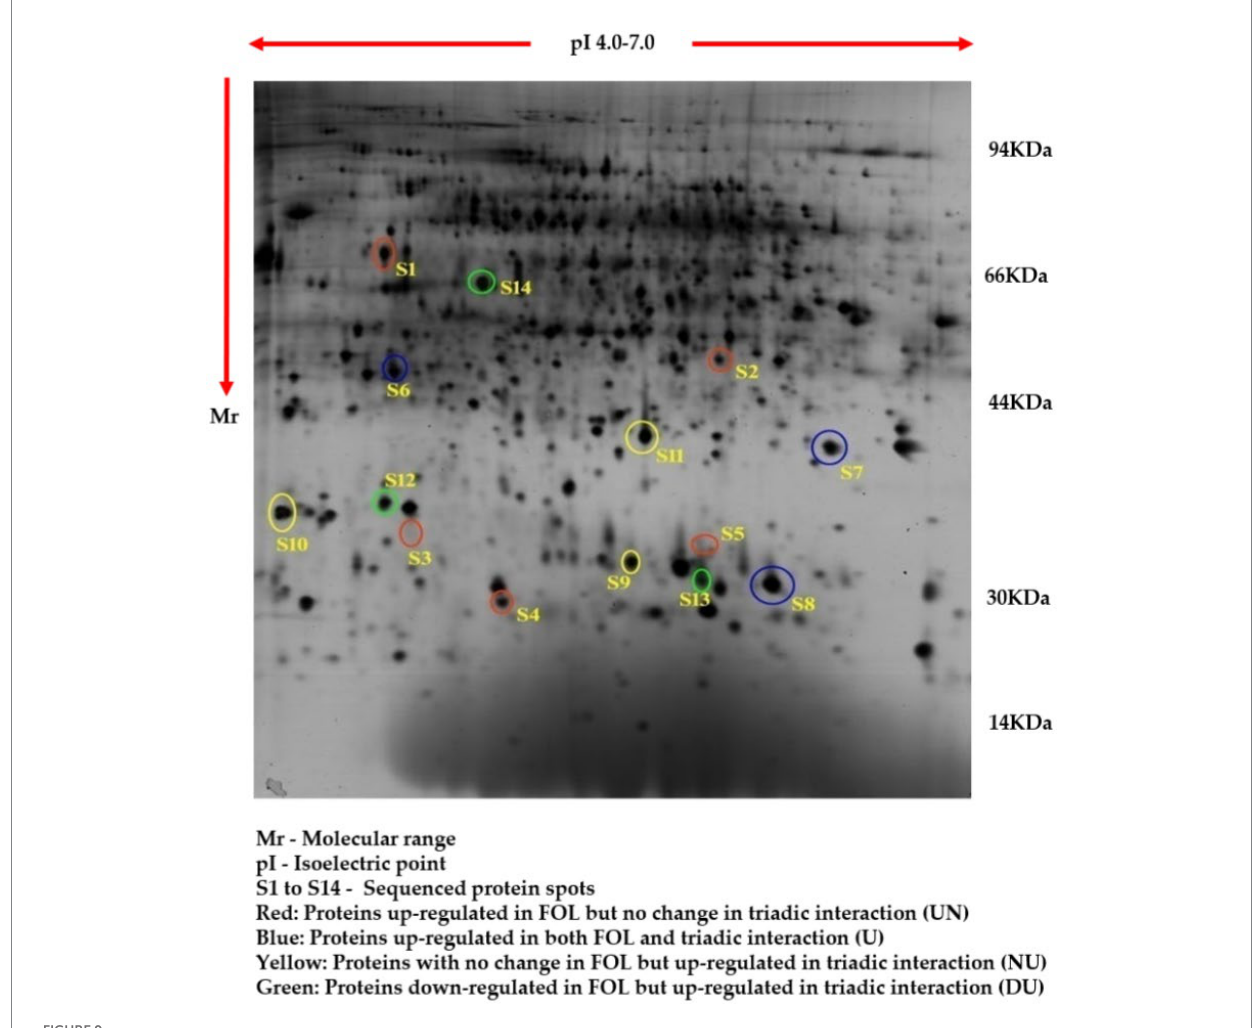
FIGURE 9 Proteome analysis of tomato roots during the triadic interactions of TPf1 biocontrol agents against FOL pathogen by